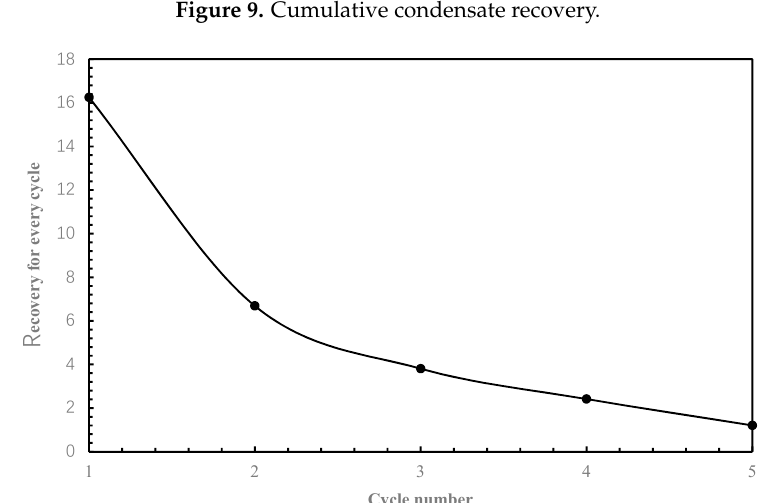
Figure 10. Increment of condensate recovery for every cycle.